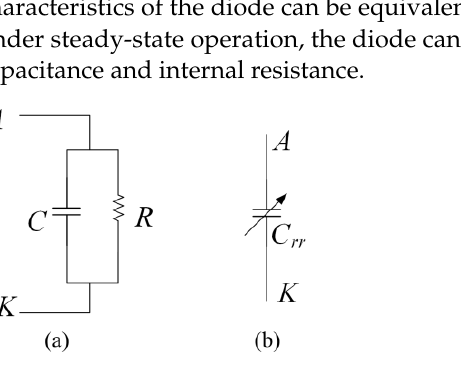
Figure 3. Dynamic equivalent circuit of diode turn-off process: ( a ) Low-frequency equivalent circuit; ( b ) high-frequency equivalent circuit.